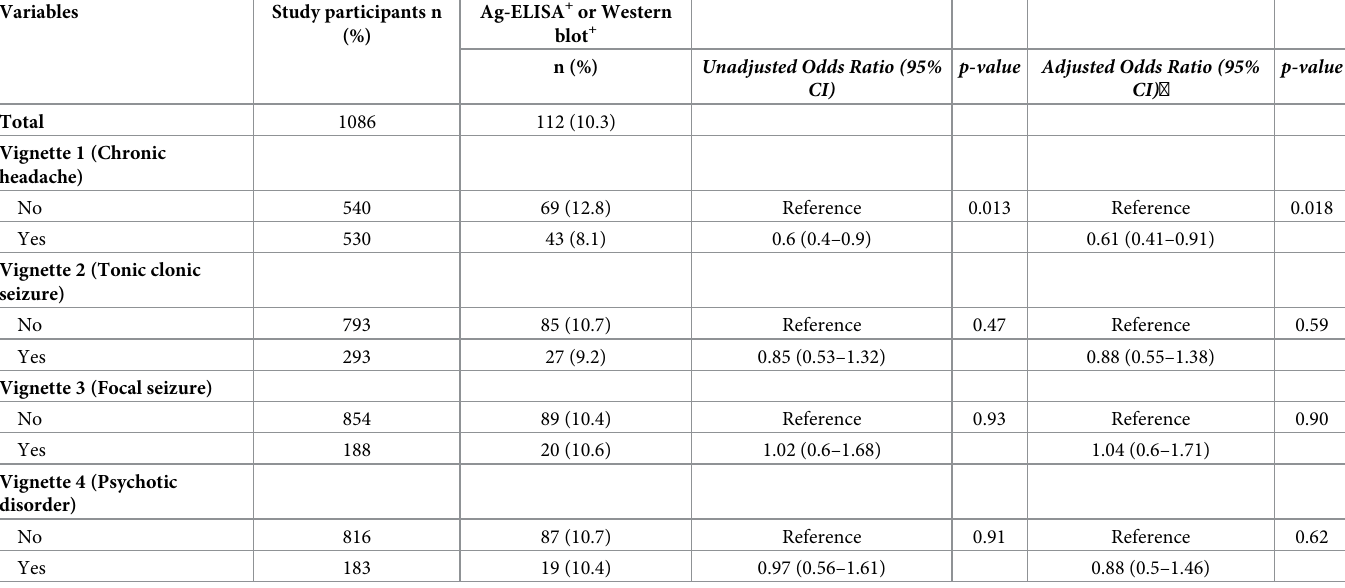
Table 4. Analysis of statistical association between screening positive for vignettes and cysticercosis serology positivity.